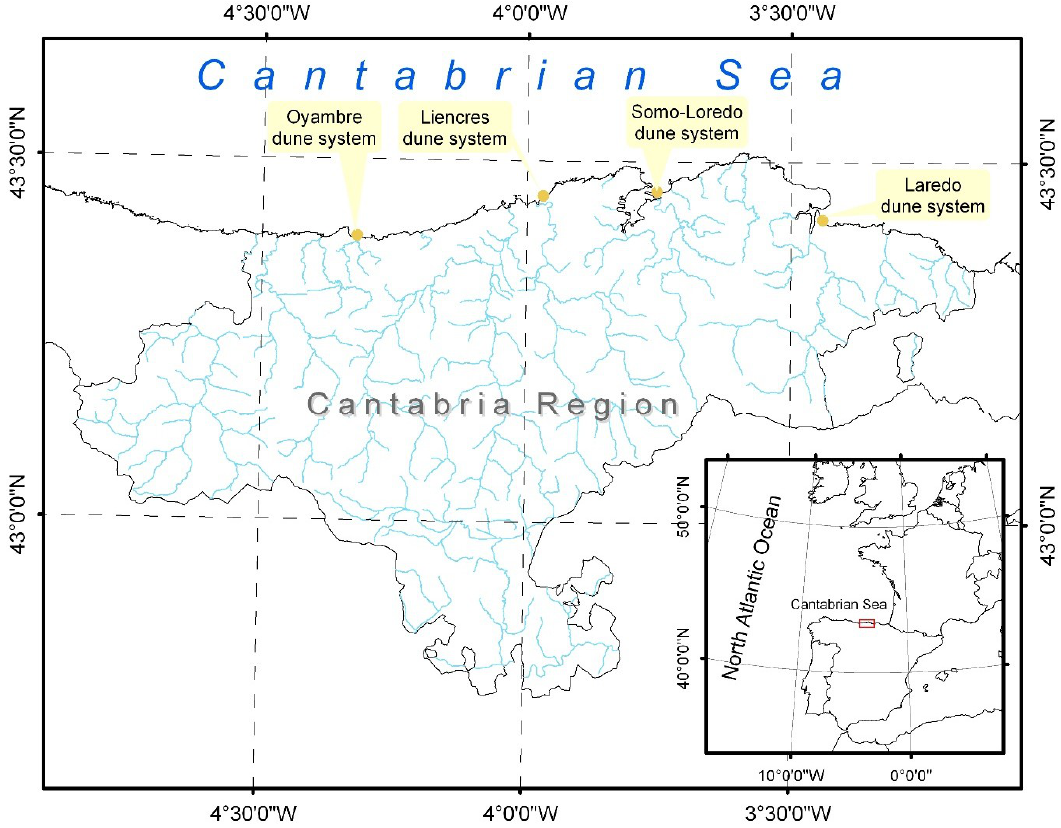
Figure 1. Map of the Cantabrian region and the four beach-dune systems selected.